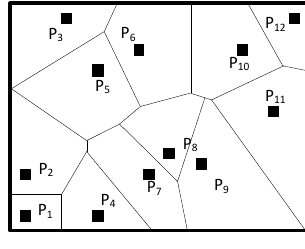
Figure 5. Voronoi diagram